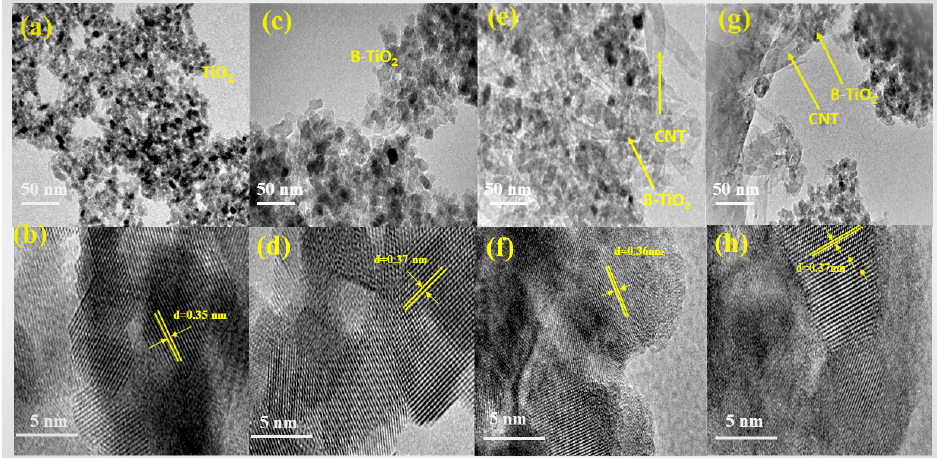
Figure 4. TEM images of ( a , b ) TiO 2 , ( c , d ) 3B-TiO 2, ( e , f ) 1B-TiO 2 -CNT and ( g , h ) 3B-TiO 2 -CNT nanocomposites.